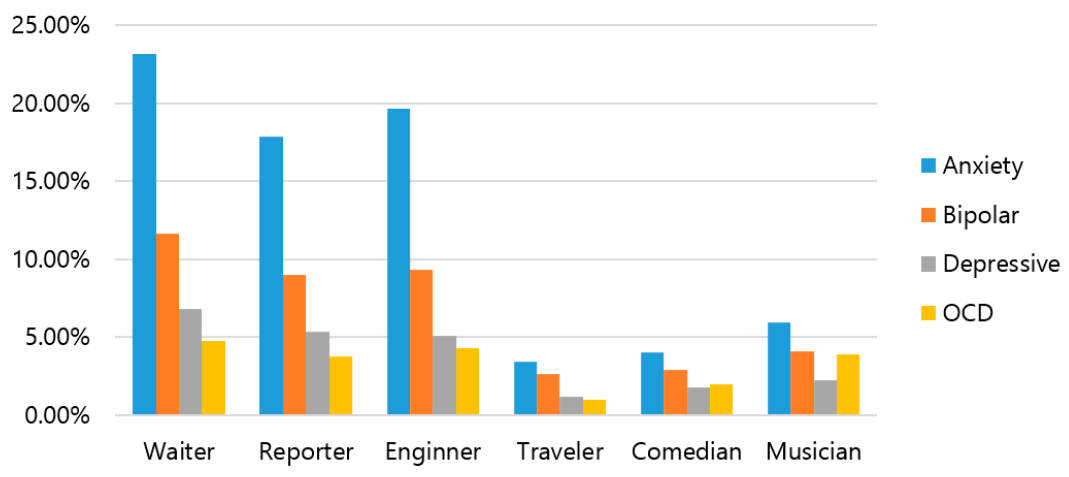
Figure 7. Distribution of mental disorder tendency among the six occupations.